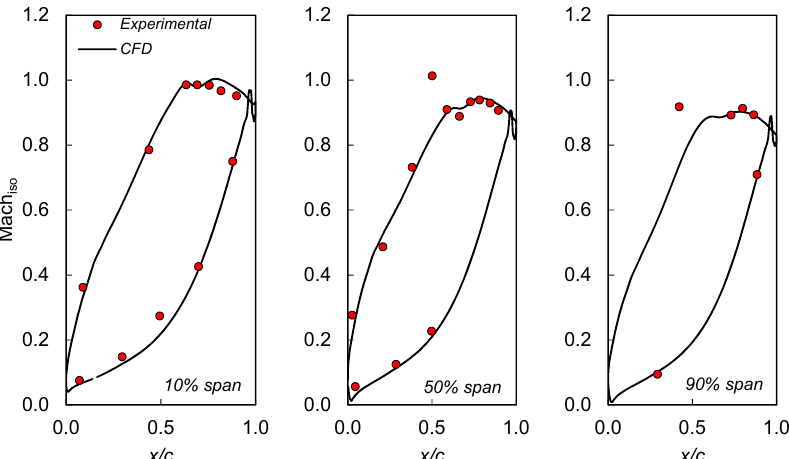
Figure 3. Comparison of isentropic Mach number at three different blade spans between experimental [23] and CFD val- ues.